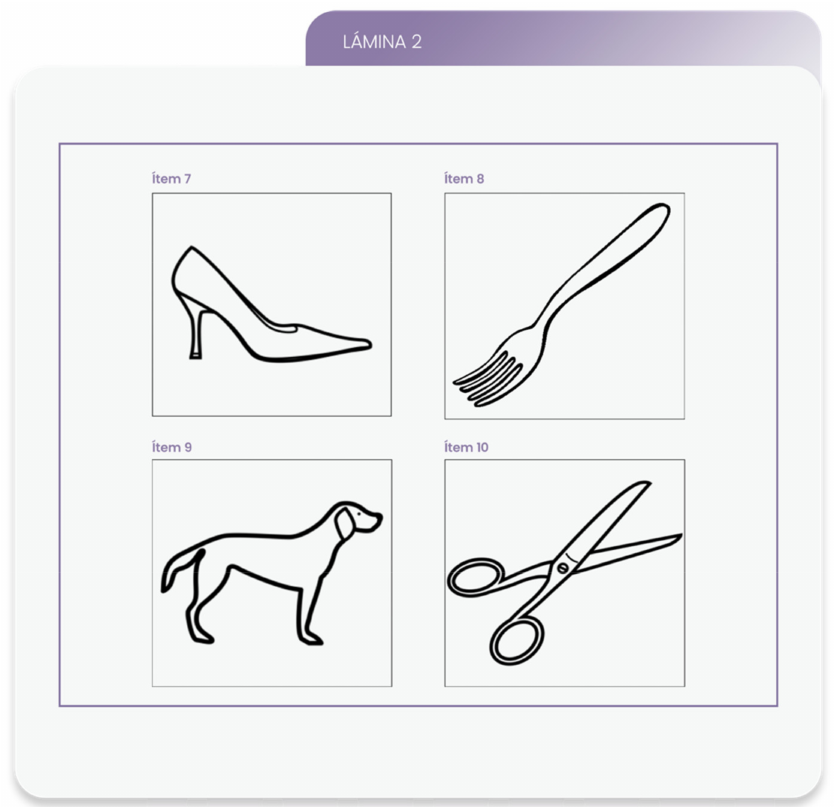
Figure 1. Pictograms used by the Aragonese Centre for Alternative and Augmentative Communica- tion to assess the area of verbal naming of